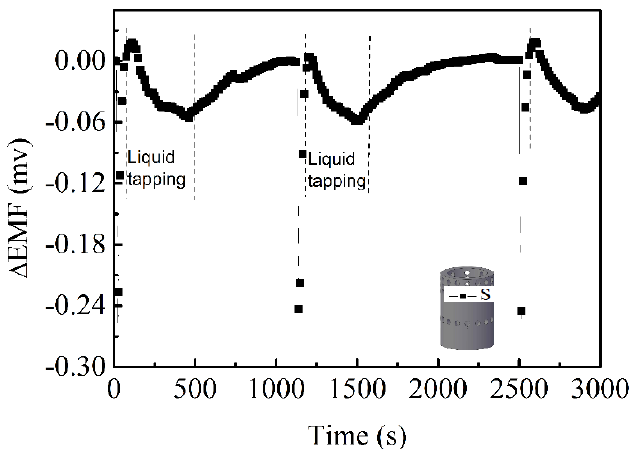
Figure 12. EMF signals on inner wall in three tapping cycles.